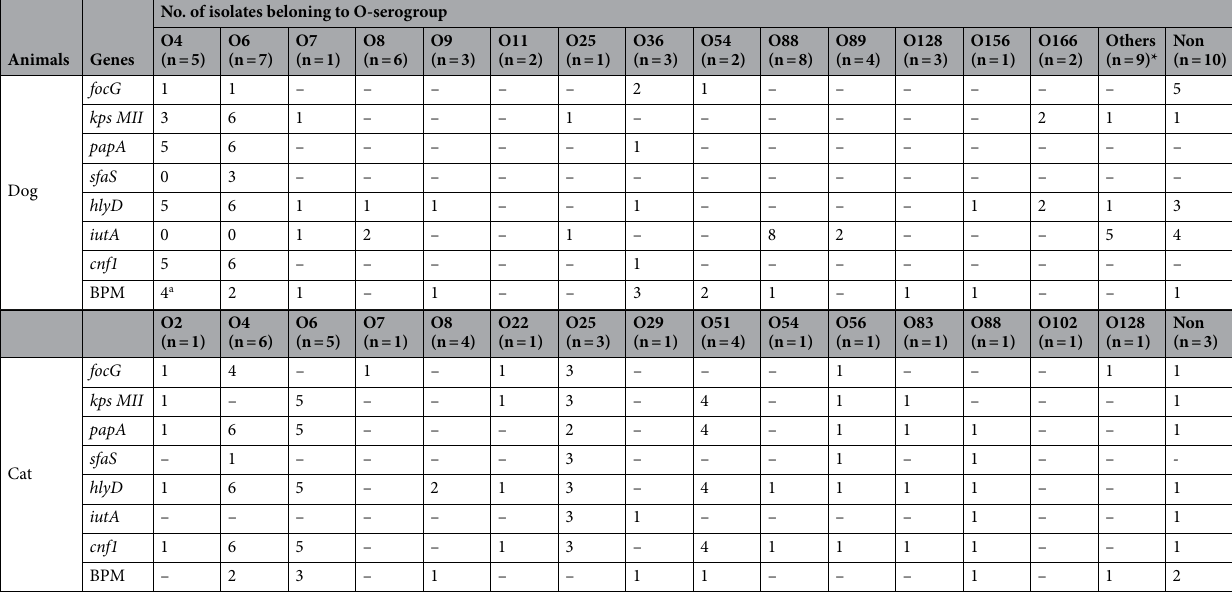
Table 4. O-serogroups and virulence factors in extraintestinal pathogenic E. coli isolates from the lung samples of dogs and cats. Non non-typeable, BPM bacterial pneumonia-induced mortality. *Others include O29, O41, O60, O78, O81, O91, O131 and O161. a Significant difference ( P < 0.05) between different O-serogroups based on bacterial pneumonia-induced